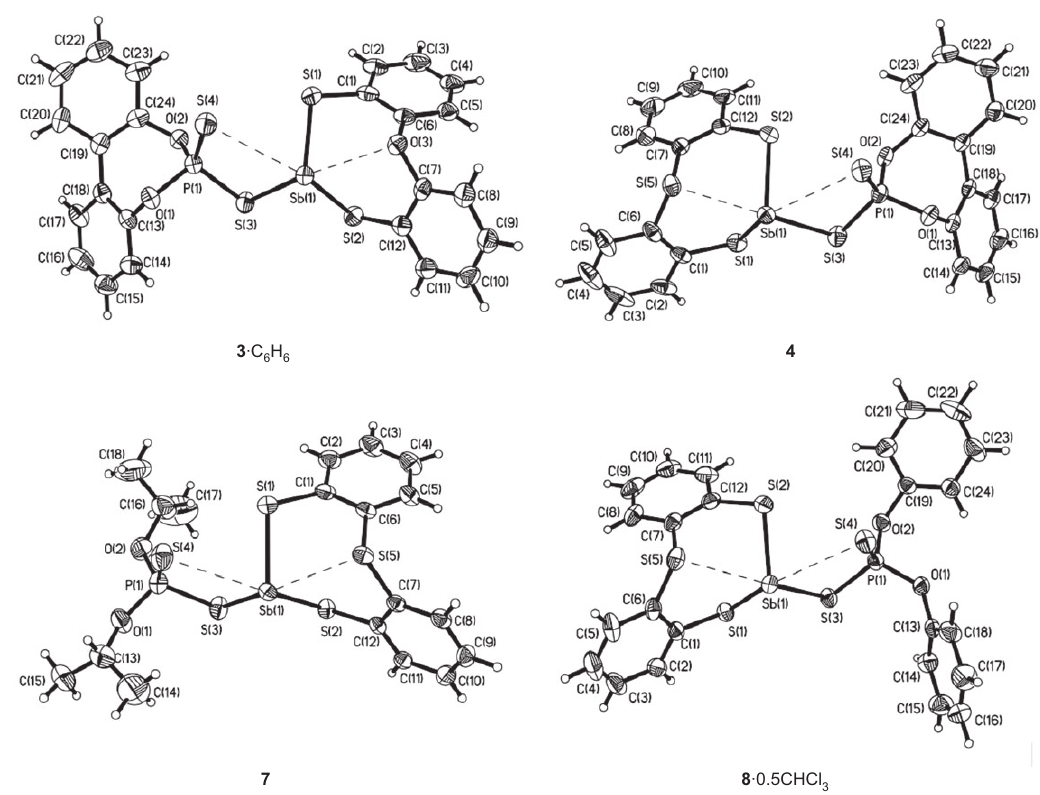
Figure 1 Molecular structure of compounds 3 , 4 , 7 , and 8 . The solvent molecules in 3 and 8 have been